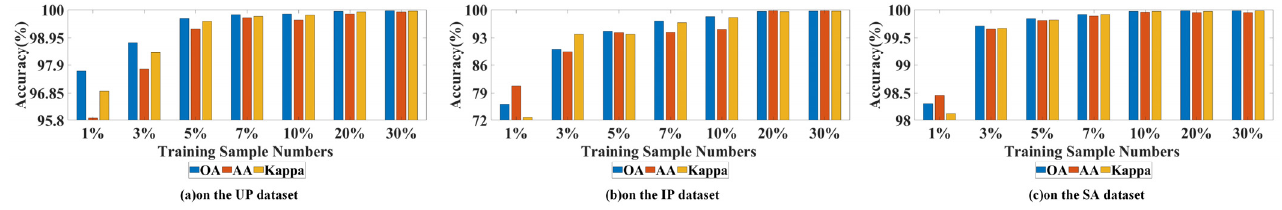
Figure 7. The effect of training sample proportions.